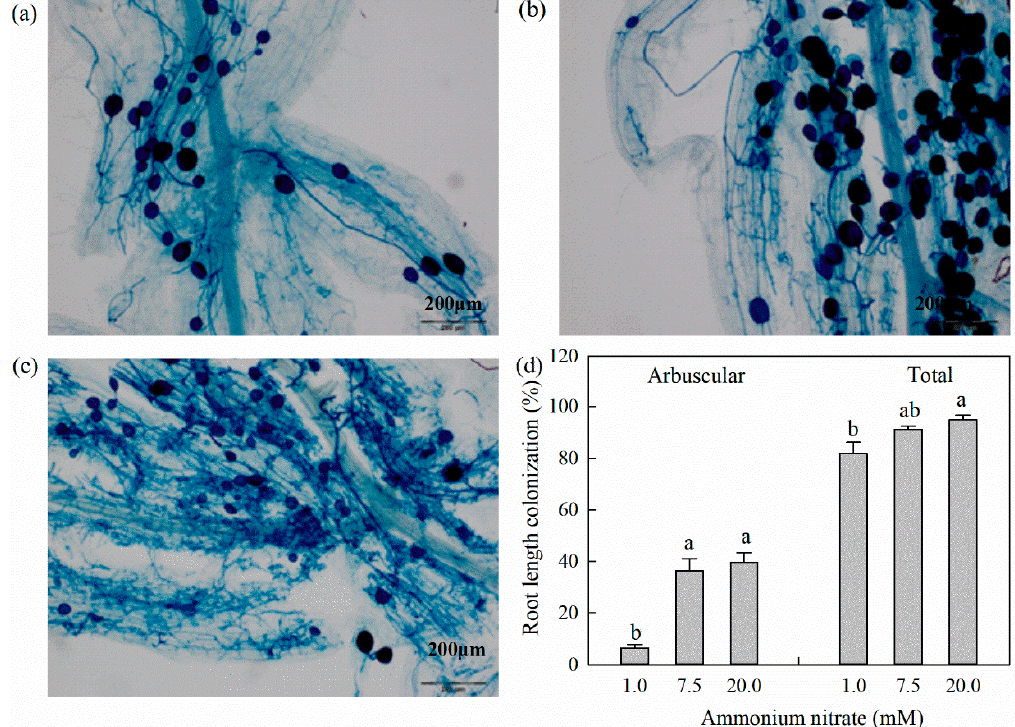
Figure 2. AM colonization rate in poplar roots under (a) low, (b) optimum, and (c) high N application levels, and the root length colonization (d). Values are presented as the means ± SE ( n = 3). Different lowercase letters indicate a significant difference at p < 0.05 according to Duncan’s test.